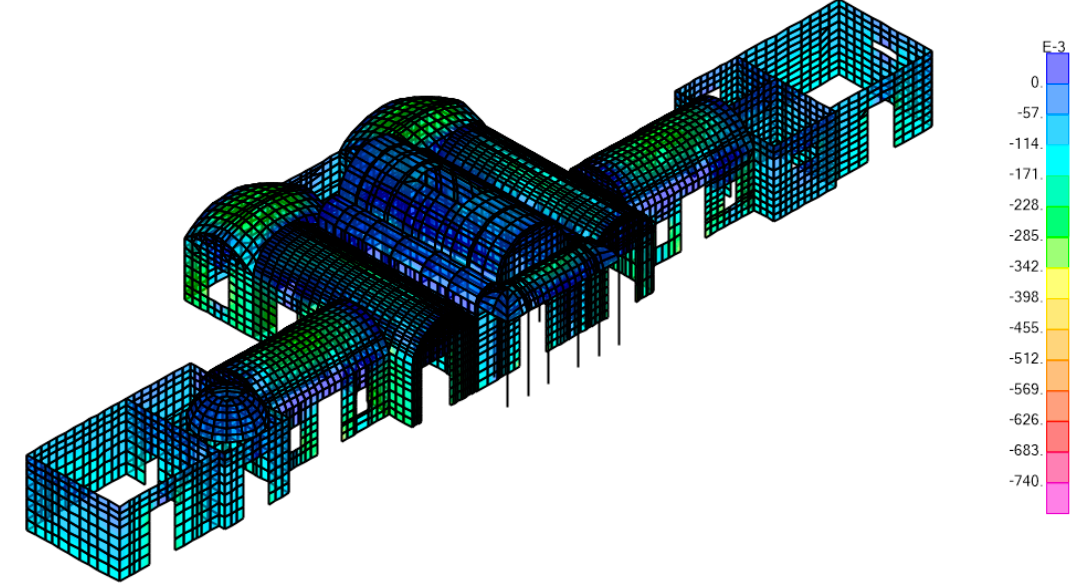
Figure 4. Maximum normal compression stresses in the main walls of the building (N/mm 2 ).